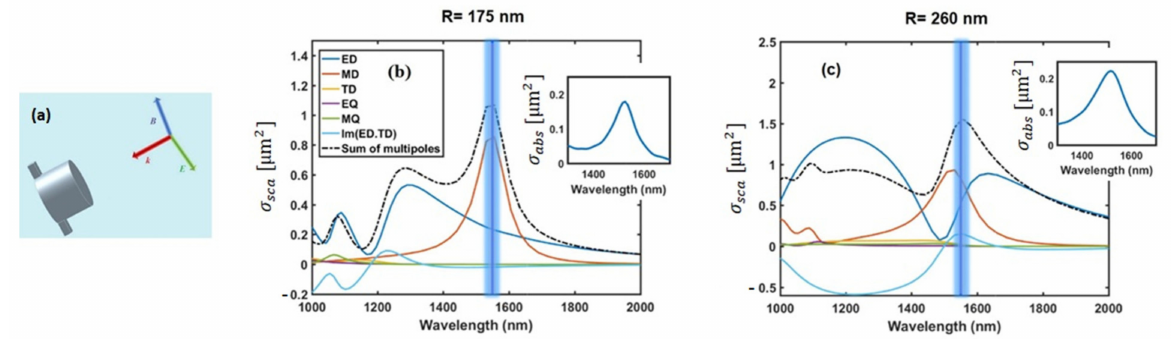
Figure 3. ( a ) Schematic of the plane wave light illuminating a single Ge nanoparticle. ( b , c ) excited modes in the single Ge nanoparticle when R = 175 ( H = 275 nm) and when R = 260 nm ( H = 205 nm). The vertical blue lines point to the wavelengths around 1550 nm (C-telecommunication